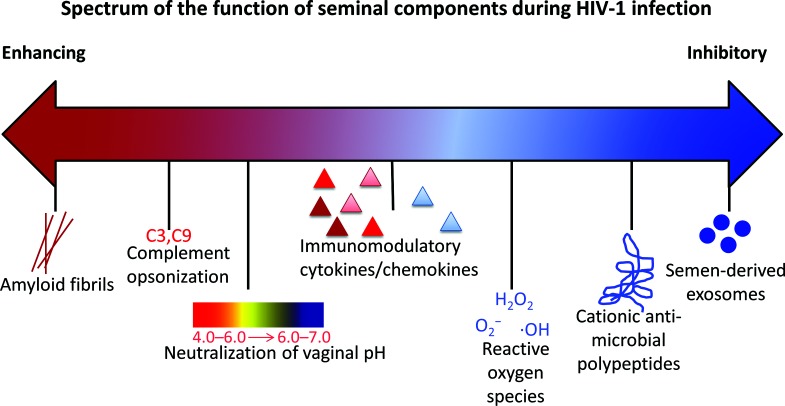
Spectrum of the function of seminal components during HIV-1 infection. HIV-enhancing components (red) and HIV-inhibitory components (blue) co-exist in seminal fluid. See text for references.